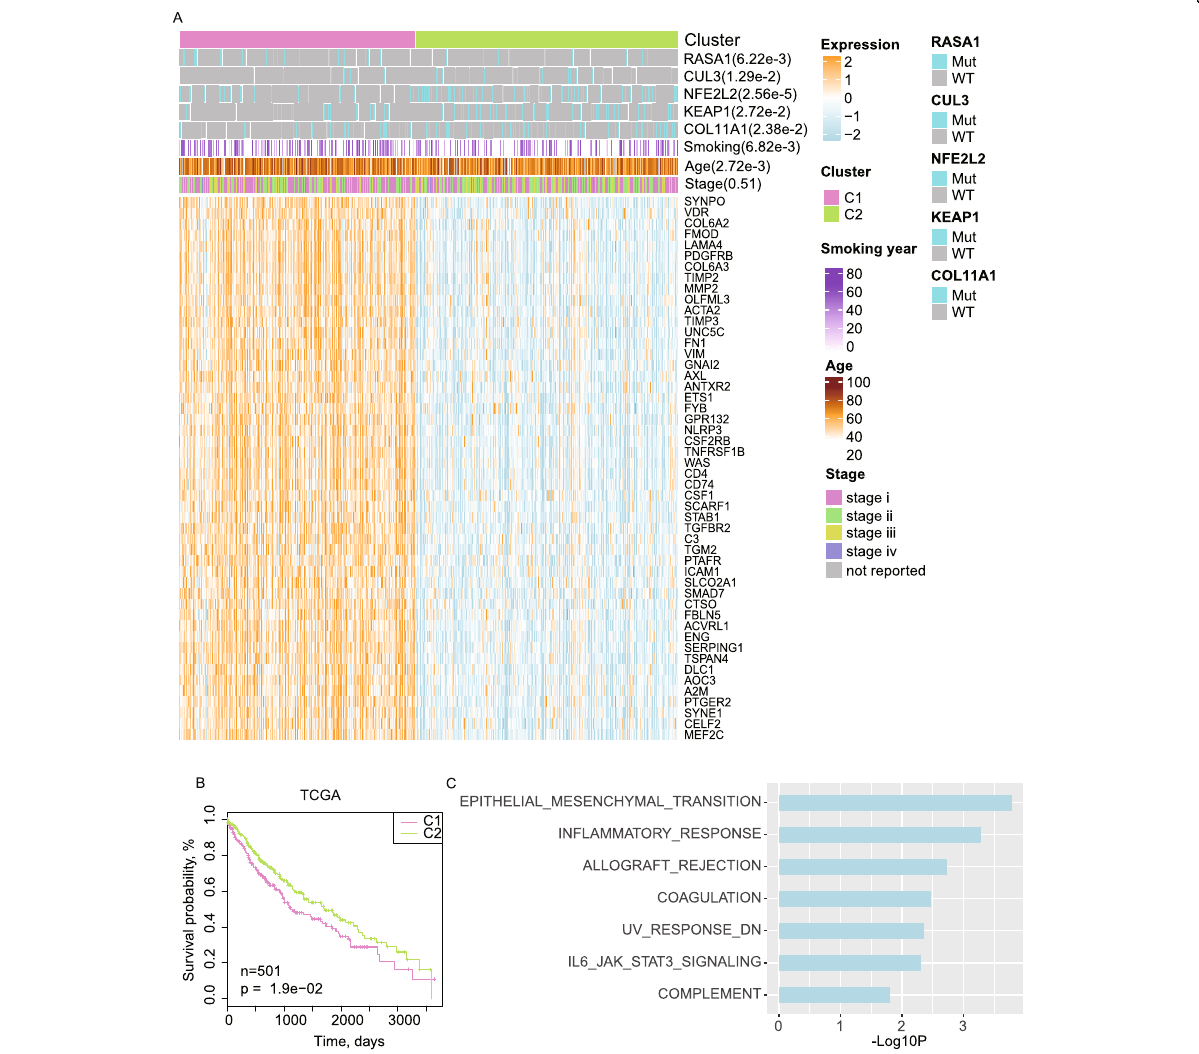
Fig. 4 Clinical influences of the somatic mutations together with relevant pathways. a Clustering the LUSC patients by their expression profiles in both the significant mutated genes and other genes in the relevant pathways. b Kaplan-Meier (KM)-plot of the 10 year overall survival curves for two clusters of patients. c Enriched pathways of the top-50 important genes for stratifying the cohort into the two clusters. The gene importance was scored by random forest